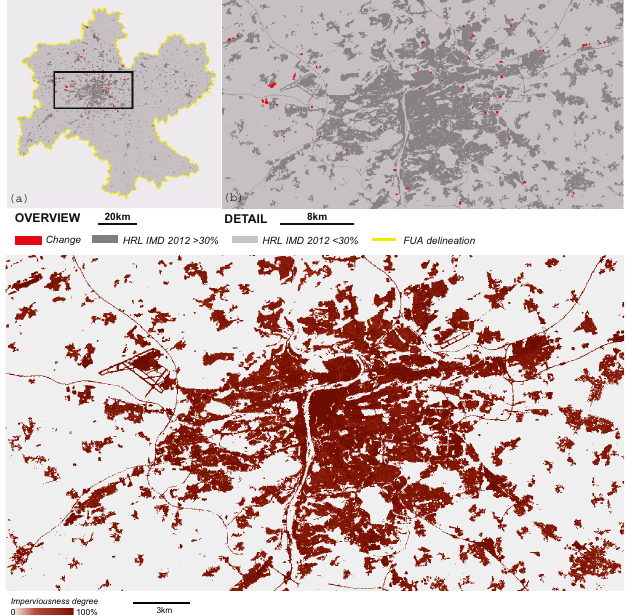
Figure 11. 2012 to 2015 change detection map in Prague. Changes have been detected by comparison of the Copernicus High Resolution Layer Imperviousness Degree (HRL IMD) (in 2012) and our product (in 2015). ( a ) The entire area; ( b ) a zoom of the black squared